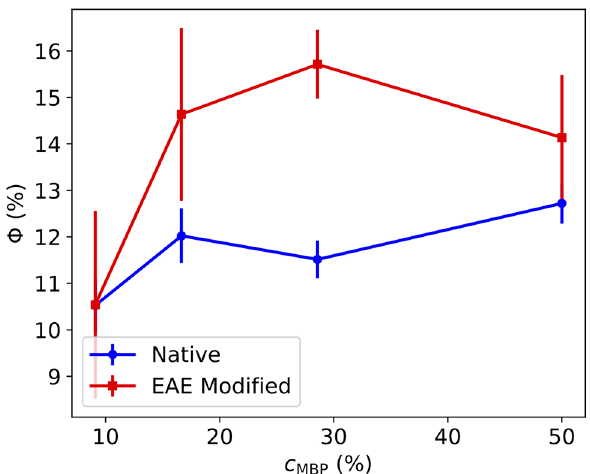
Figure 2. MLV fraction of the fits of native and EAE modified liposomes with MBP (9, 16.7, 28.6 and 50 wt.